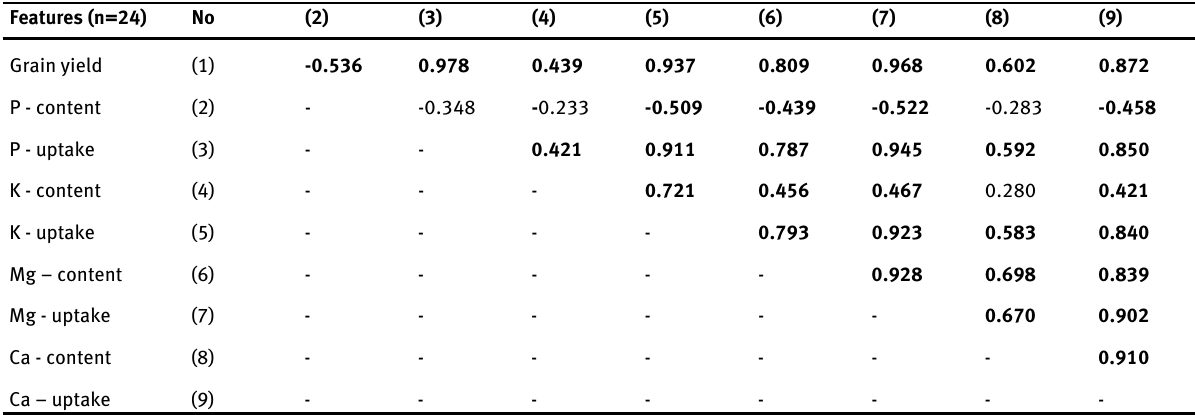
Table 3: Correlation coefficients between grain yield and grain quality characteristics. Features